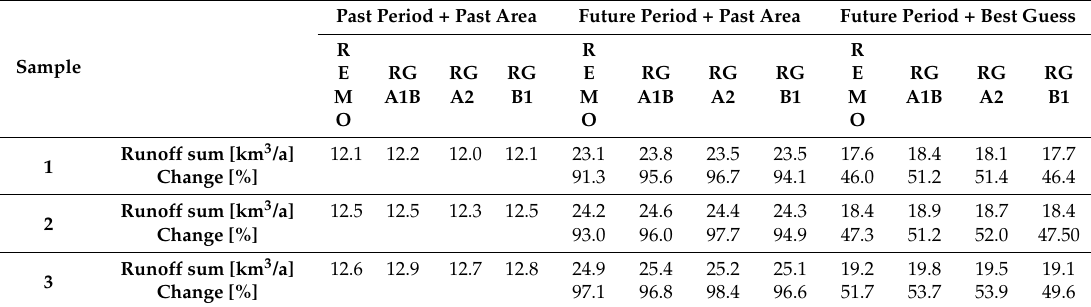
Table 5. Annual runoff sums of all samples in the Past Period with Past Area, Future Period with Past Area and Future Period with Best Guess. Change from Past Period to Future Periods shown in %.